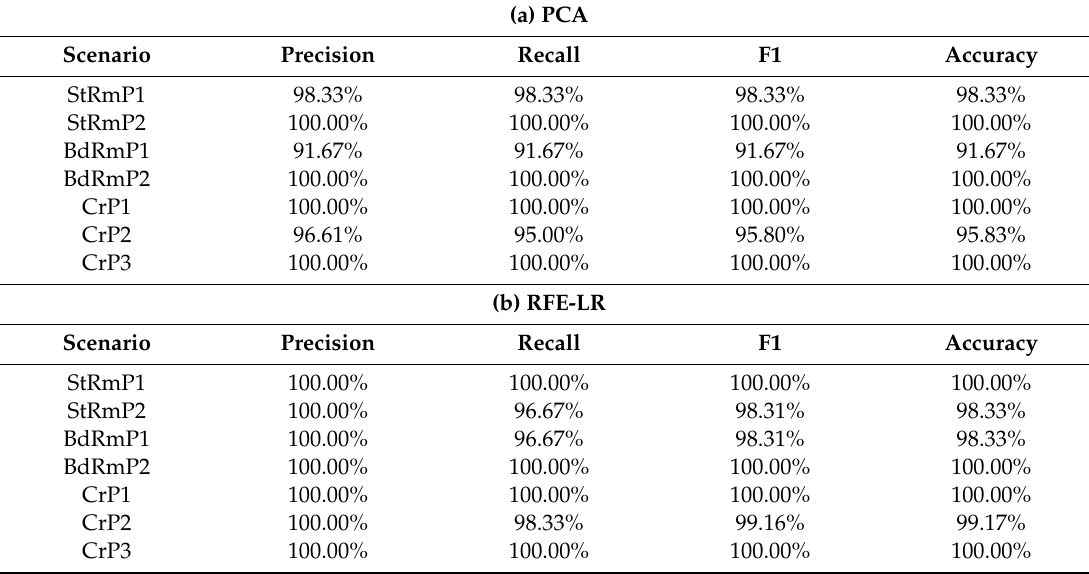
Table 4. The performance of the SGD model.